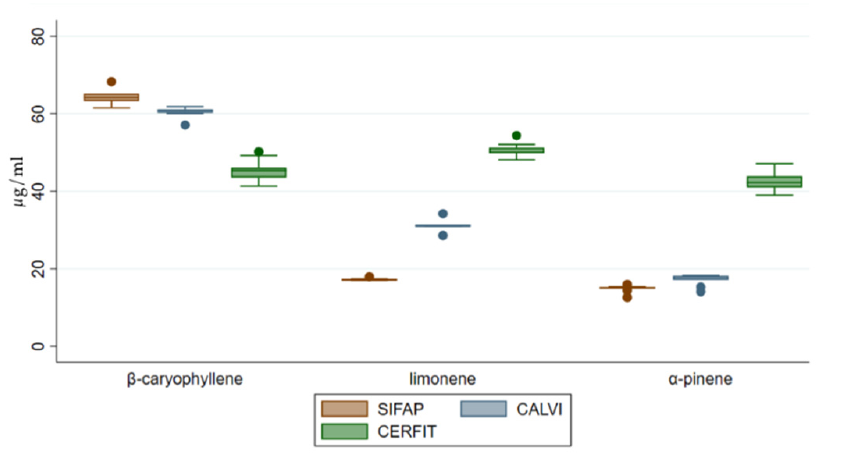
Figure 5. Distribution of concentrations of β -caryophyllene, limonene and α -pinene in medical Cannabis oil preparations extracted by three different